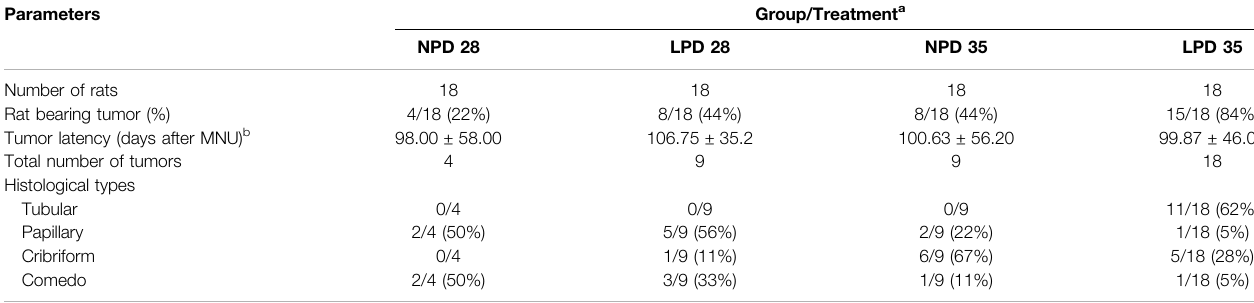
TABLE 2 | Effects of maternal low-protein diet at gestation and lactation on MNU-induced mammary tumors in female offspring. Parameters